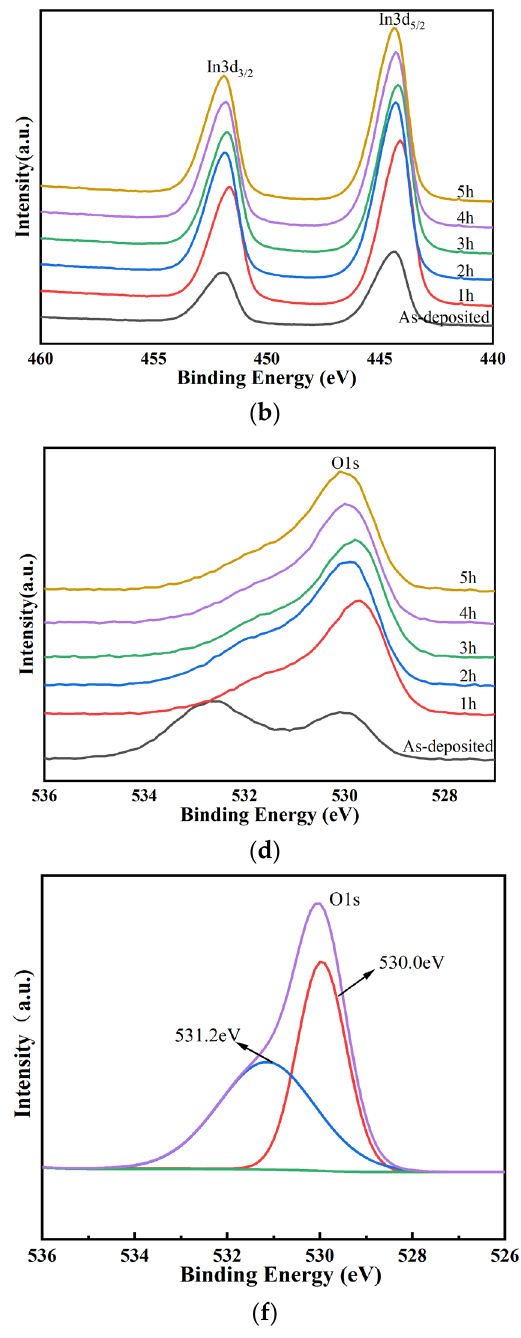
Figure 4. XPS of the ITO thin film: ( a ) full-spectra ( b – d ) XPS high-resolution peaks of In 3d, Sn 3d, and O1s, respectively; ( e , f ) XPS high-resolution peaks of O1s of as-deposited and 1 h.